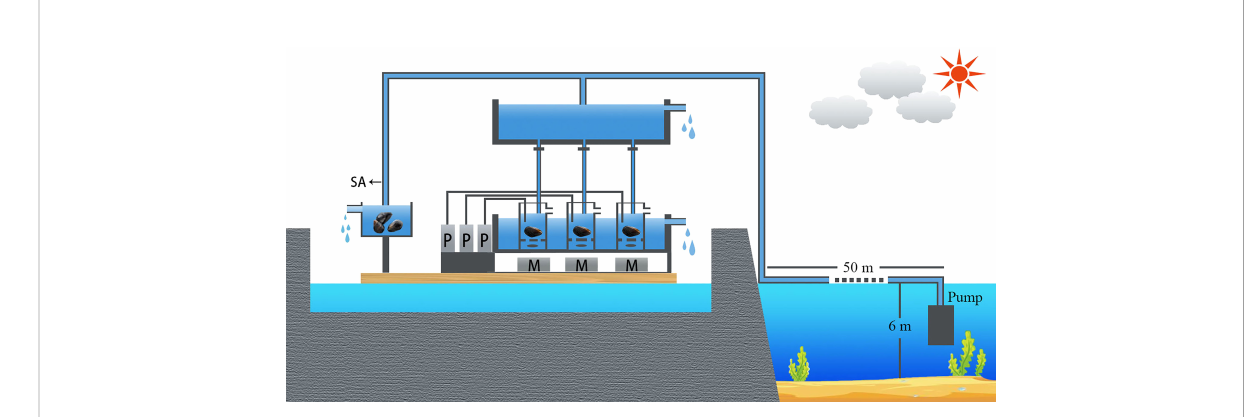
FIGURE 1 Feeding experiments in the Sungo Bay. (P, PAMAS; M, Magnetic stirrer; SA, Maintenance of M. coruscus